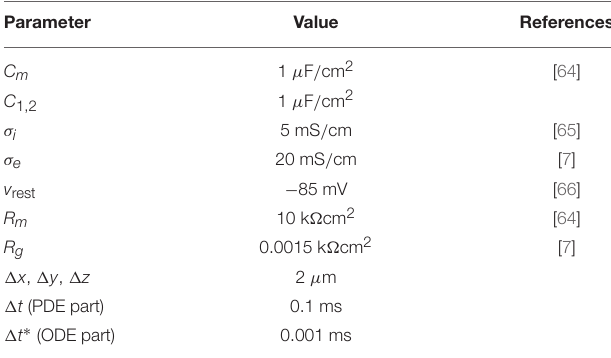
TABLE 1 | Default parameter values used in the